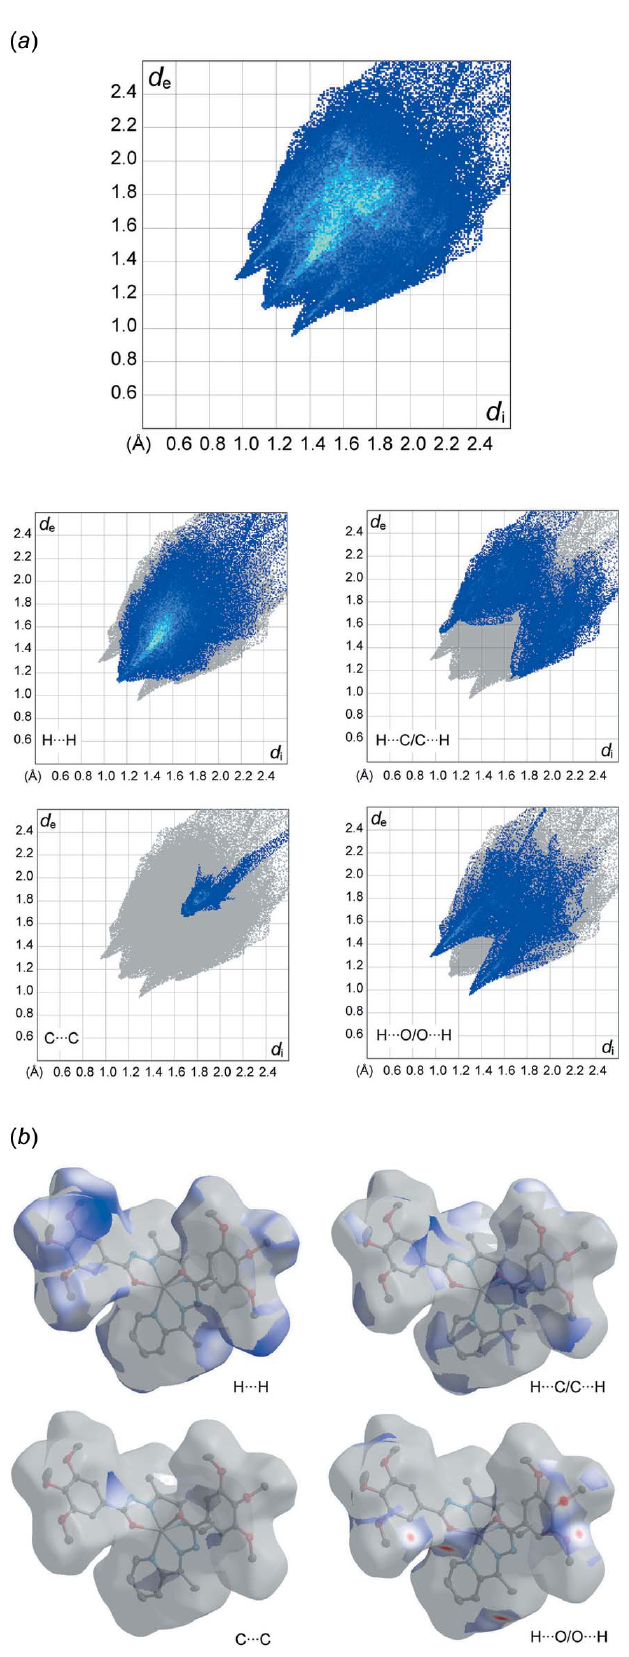
Figure 4 ( a ) The overall two-dimensional fingerprint plot and those decomposed into specified interactions. ( b ) Hirshfeld surface representations with the function d norm plotted onto the surface for the different